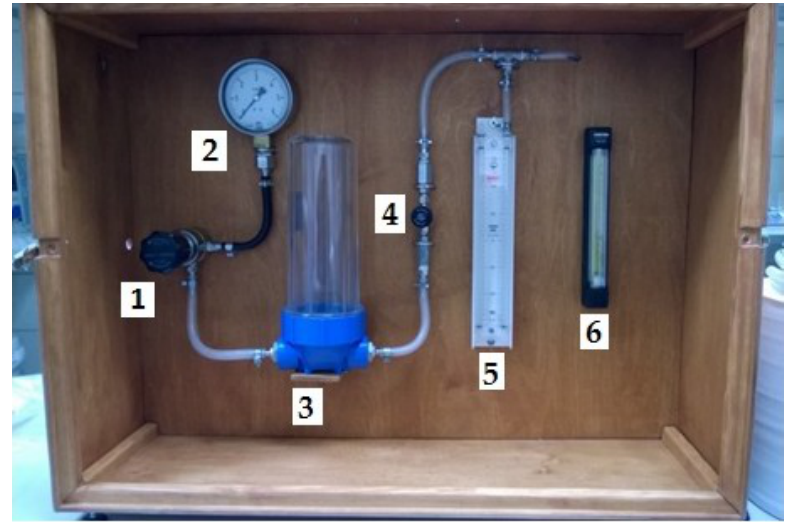
Figure 6. Gas permeability measuring station for the ceramic molds, where: (1) diaphragm valve, (2) circular manometer, (3) dryer, (4) needle valve, (5) liquid manometer, and (6) flowmeter.